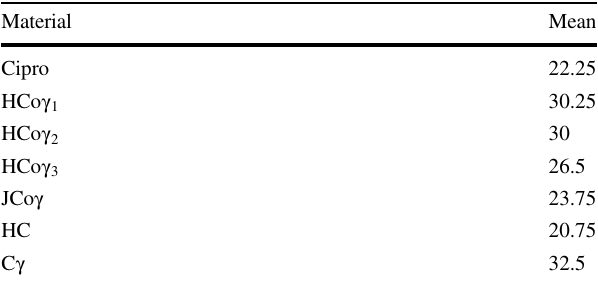
Table 3 Biomaterials and the mean diameters of the halos formed around each of